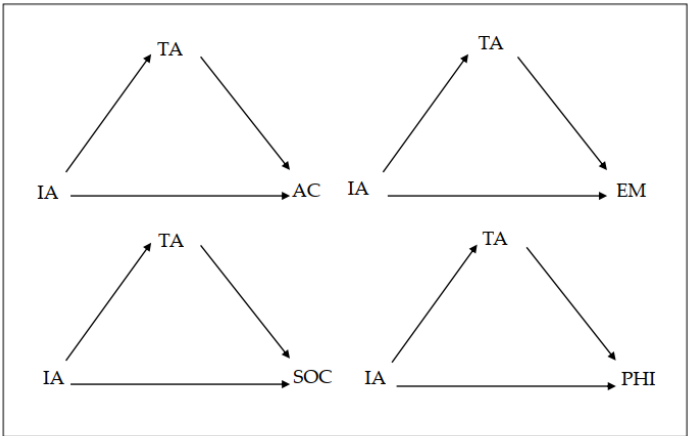
Figure 1. Mediational model for inattention symptomatology. AC = Academic self-concept; EM = Emotional self-concept; SOC = Social self-concept; PHI = Physical self-concept; TA = Trait anxiety; IA= Inattention symptomatology.